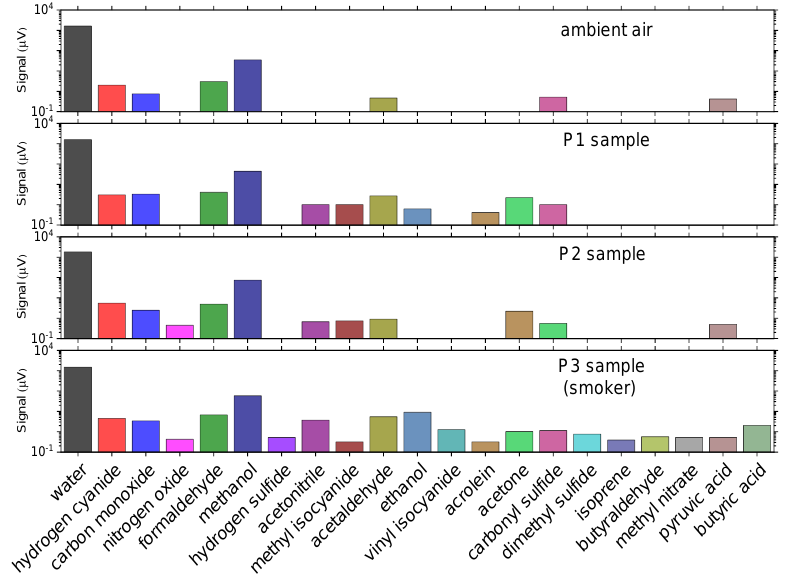
Figure 24. Gases detected in exhaled human breath. Adapted from [180].